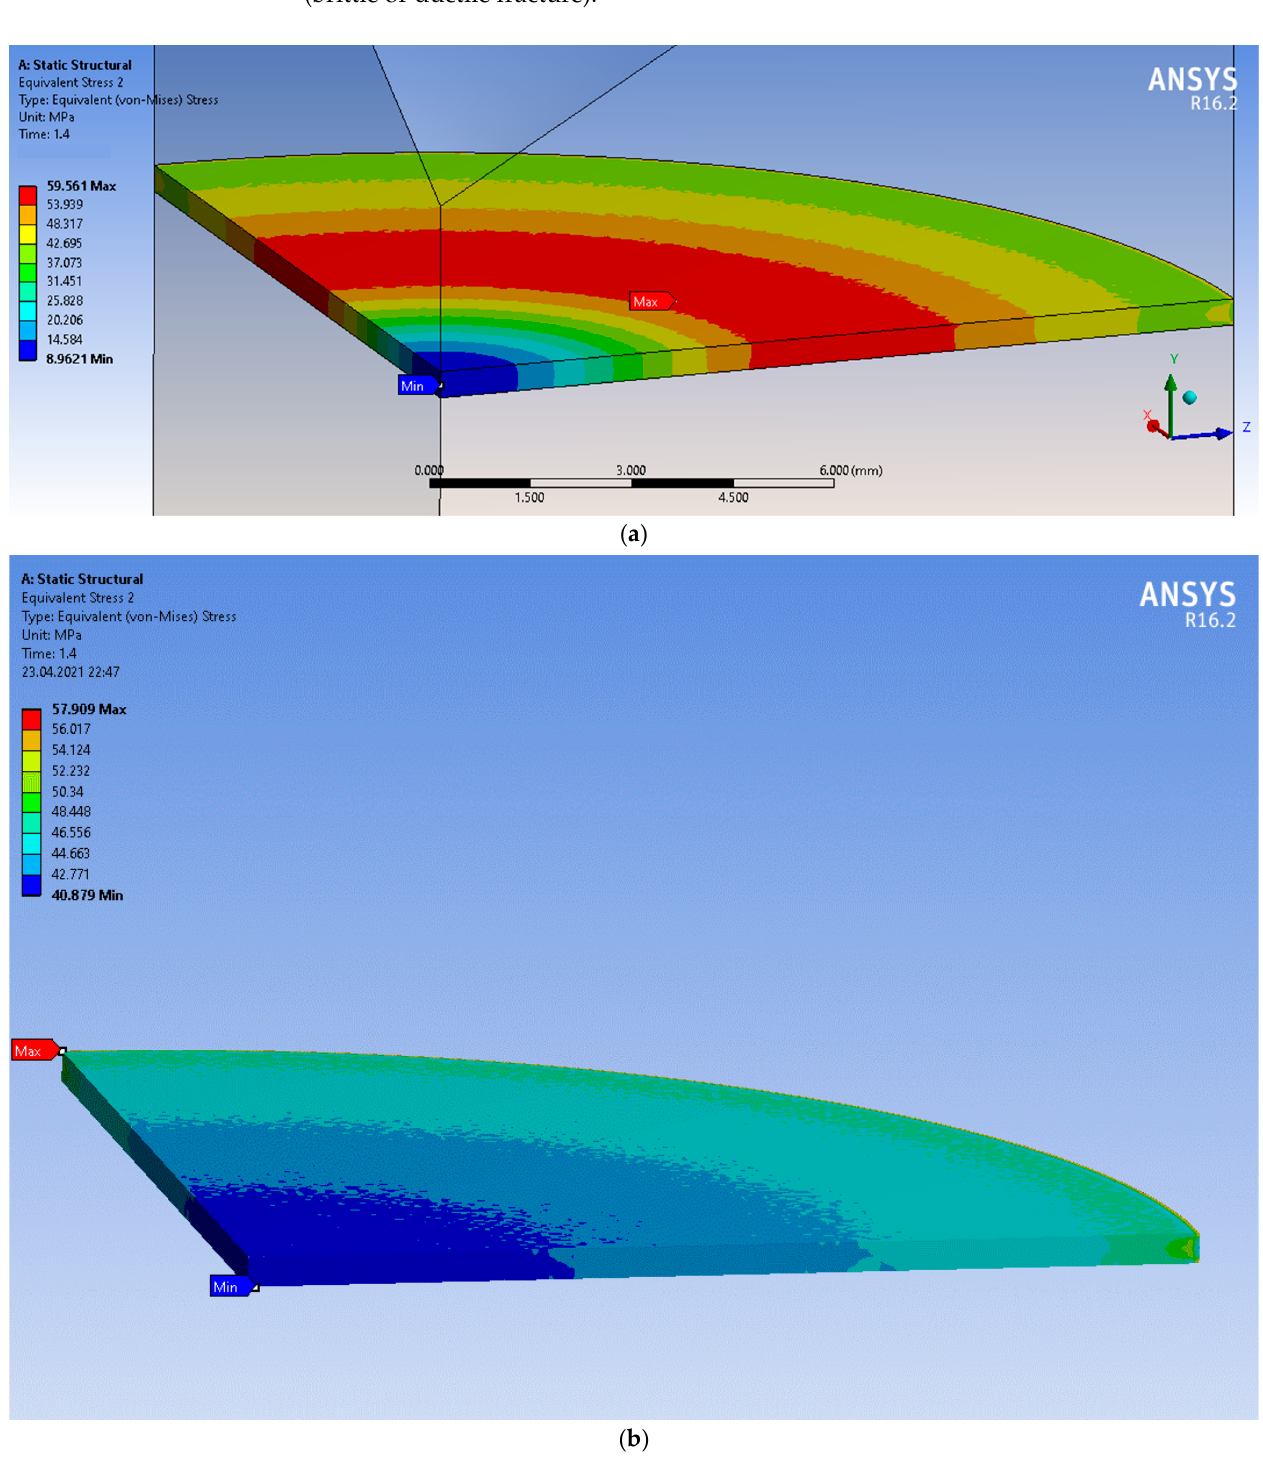
Figure 6. Equivalent stress distribution at the debonding area of the Al 2 O 3 coating with a tensile force of F = 14,000 N: ( a ) GOST 9.304-87 standard specimen, type 1; ( b ) Elongated specimen, type 4. For geometric parameters, see Figure 2.